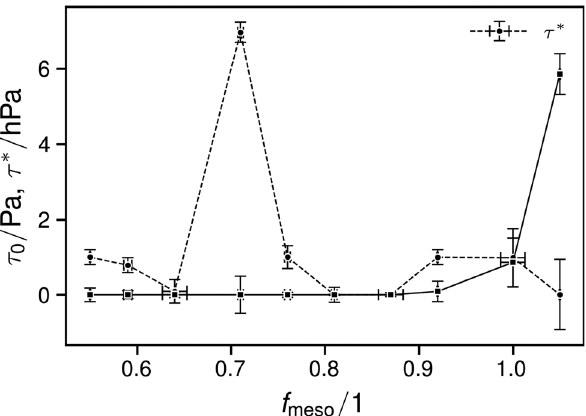
Figure 9: Yield shear stresses τ 0 ( squares and full lines ) and tran - sitional shear stresses τ ∗ ( circles and dashed lines )